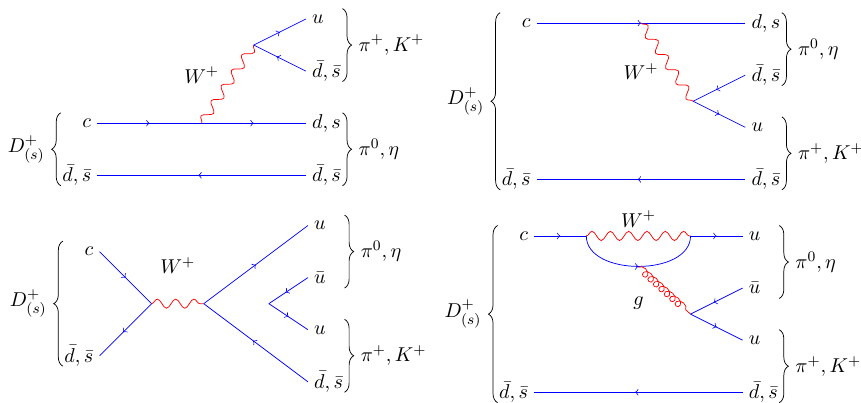
Figure 1. Processes that contribute to the studied decays at tree-level include (top left) colour- favoured, (top right) colour-suppressed and (bottom left) annihilation topology decays. Contribu- tions can also be received at loop-level from processes such as (bottom right) penguin topology